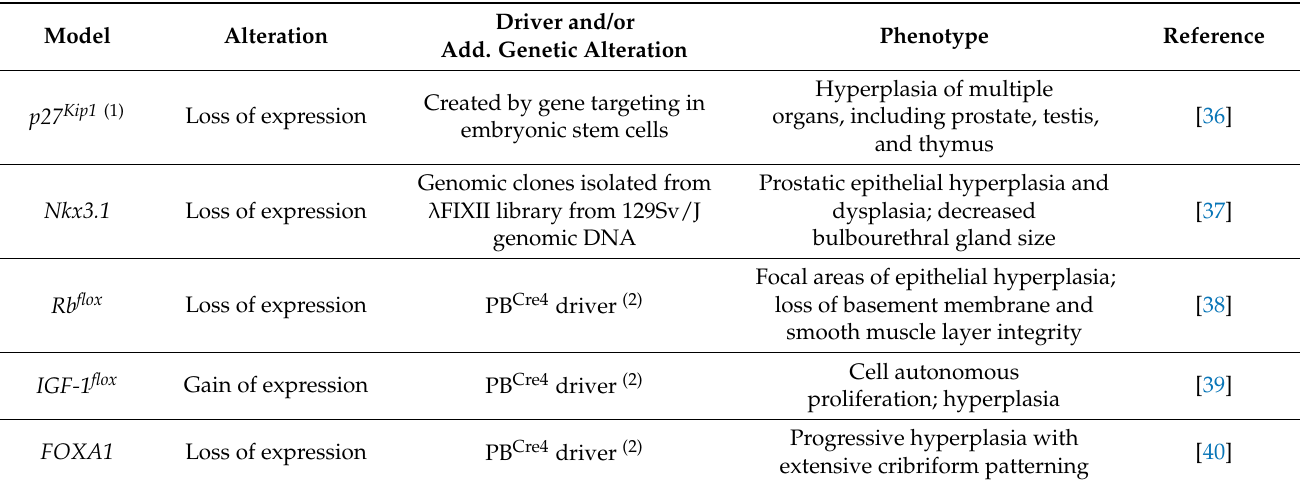
Table 2. PCa models in which hyperplasia is